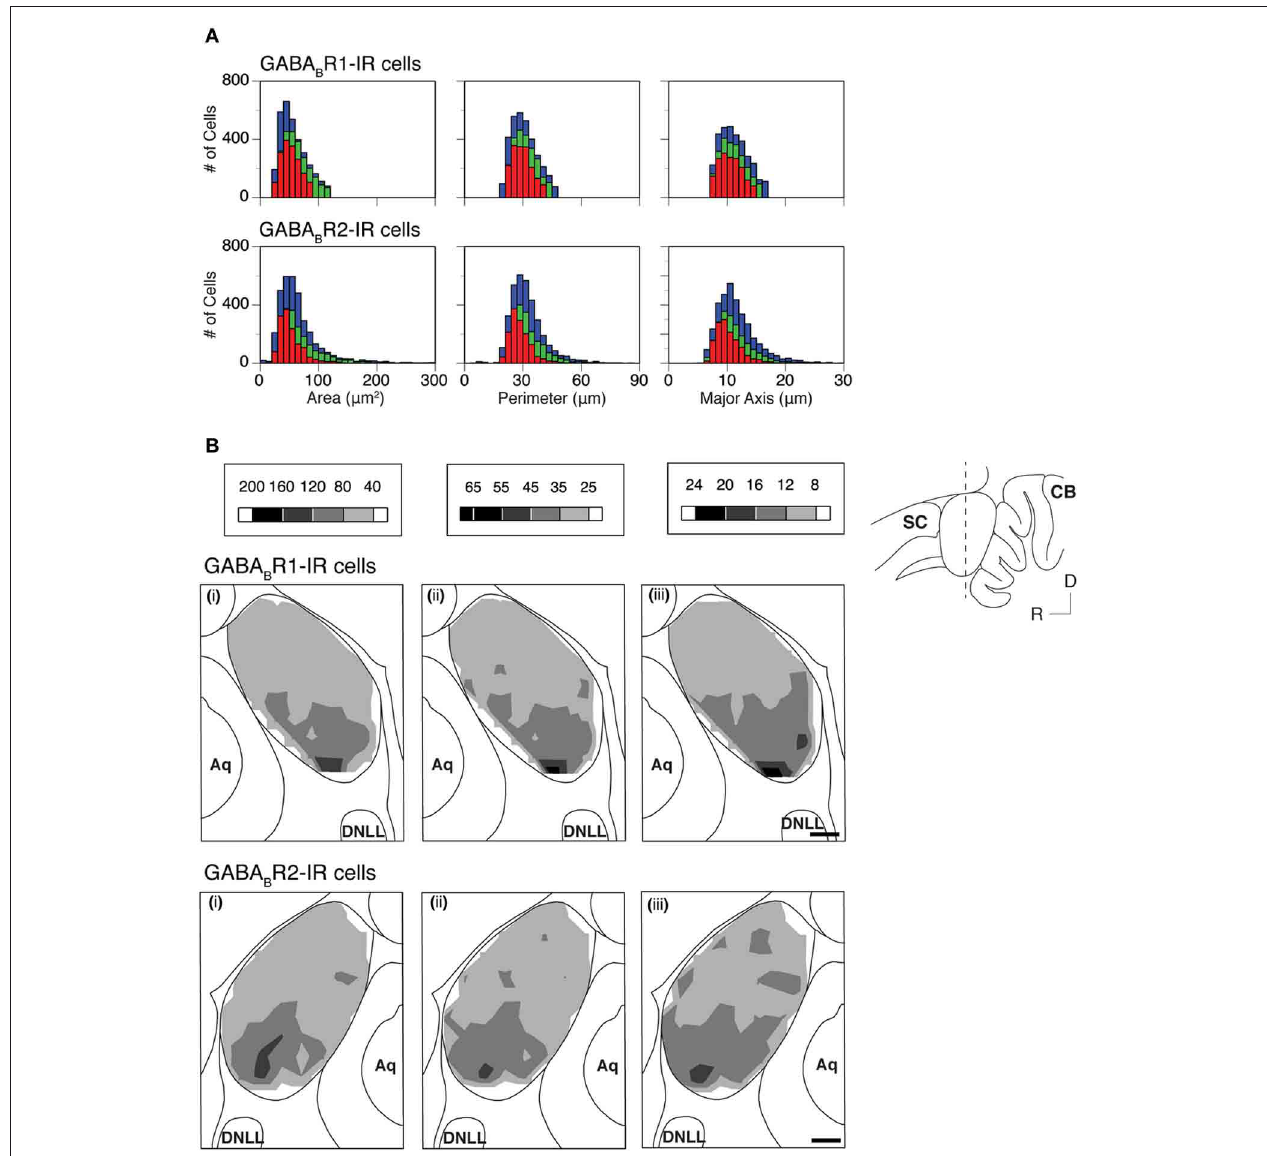
IC in a coronal section as indicated in the inset. A mean area, a mean perimeter, and a mean major axis were obtained by using the corresponding parameters from all the labeled cells in a 150 × 150 μ m grid box. A contour is made by using the mean values from all the alternating grid boxes over the area of the IC. Results in the top panels of (B) are from the same animal as in the top panels of (A) while results in the bottom panels of (B) are from the same animal as in the bottom panels of (A) . Scale bars in (B) : 500 μ